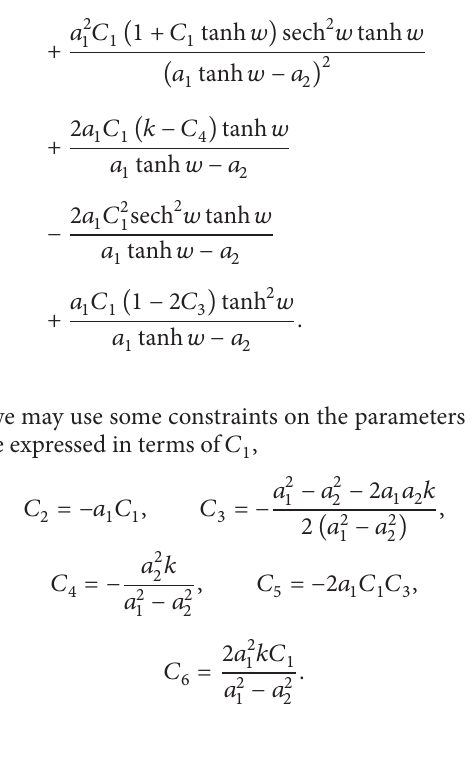
Figure 1: The graphs of (a) component of the vector potential 𝐴 𝑢 (𝑤) in (19), effective models (b) 𝑉 of 𝐶 1 = 0.4 , 𝐶 2 = 0.5 , 𝑅 = 1 , 𝐶 3 = 𝑘 + 1 , and 𝑘 = 2 , and (d) the energies ±𝐸 1,𝑛 in (27) for 𝑘 = 200 . There are bound states only for 𝑛 = 0, 1, 2 and 𝑉 is an increasing function in the positive domain while 𝑉 eff ,2 𝐴 𝑉 𝑢 is similar to eff ,1